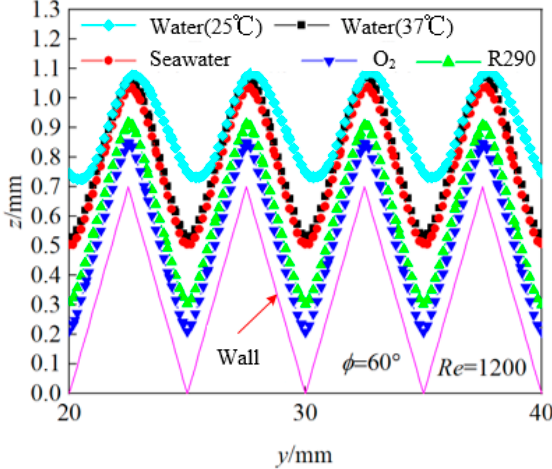
Figure 6. Film surface position z for different fluids.